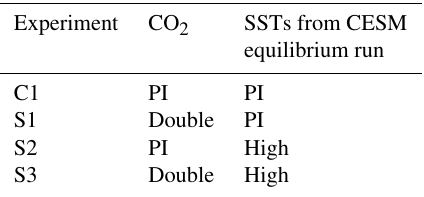
Table 1. Setup of the model experiments. Note: Community Earth System Model –